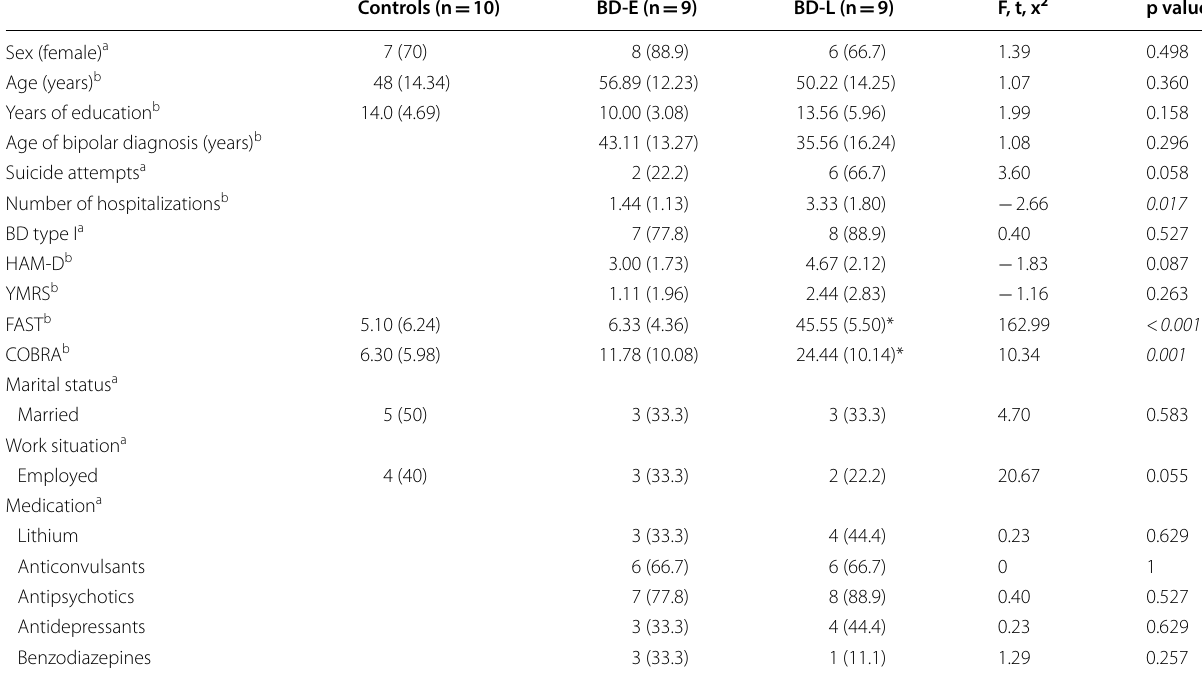
Table 1 Characteristics of the